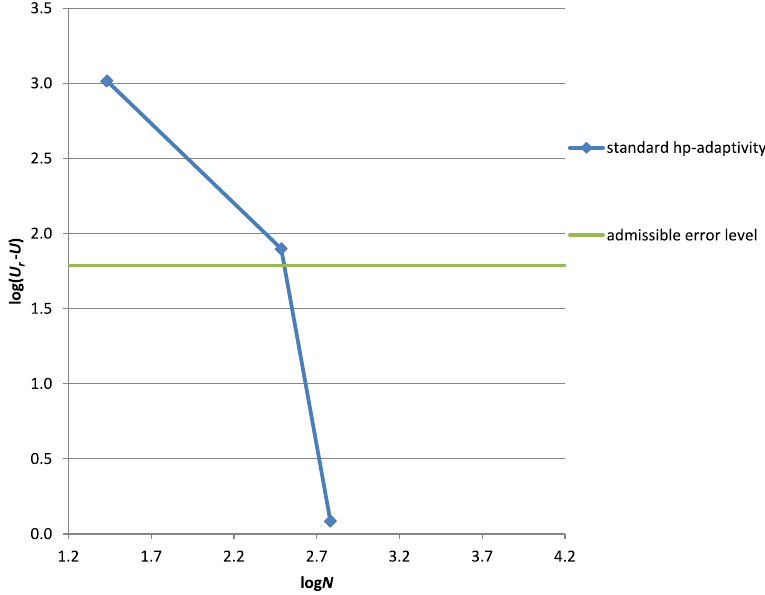
Figure 29. An octant of a membrane-dominated shell—convergence for hp -adaptation. Table 4. Result summary—an octant of the membrane-dominated